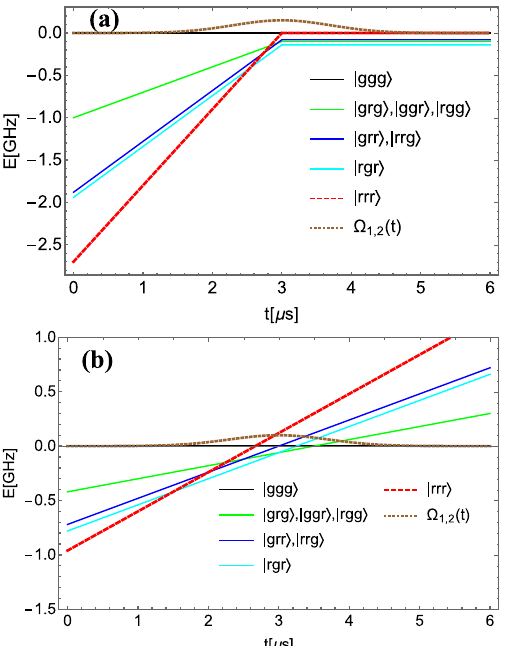
Figure 2. The quantum control scheme was deduced from the mathematical analysis of the Hamiltonian in the field-interaction representation. The energies of the required bare states were equated to derive the time of the resonance, (see below). From the consideration of the Hamiltonian matrix elements it follows that since V ij > 0 in the expressions of the bare state energies, in order to achieve an avoided crossing with the ground collective state having zero energy, the detunings have to be negative and the chirp rate has to be negative to provide a positive slope. ( a ) The energies of a subset of the bare states dependent on the two-photon detuning δ and the chirp in the field interaction representation as a function of time obtained using the control parameters designed 0 for t > t res ; δ = − 100 MHz=− 2/3 V max , t res and α to generate the GHZ state: α = − 150 MHz/ µ s for t ≤ = 2 V 31 60 MHz, the pulse duration is τ 0 1 µ s; ( b ) The energies of a subset of the bare V 21 V 32 V = = = = = states dependent on the two-photon detuning and the chirp in the field interaction representation as a function 60 MHz, 1 µ s, δ of time for the control parameters designed to generate the W state: α = − 60 MHz/ µ s, τ 0 = − = 2 V 31 60 V 21 V 32 V = = = =